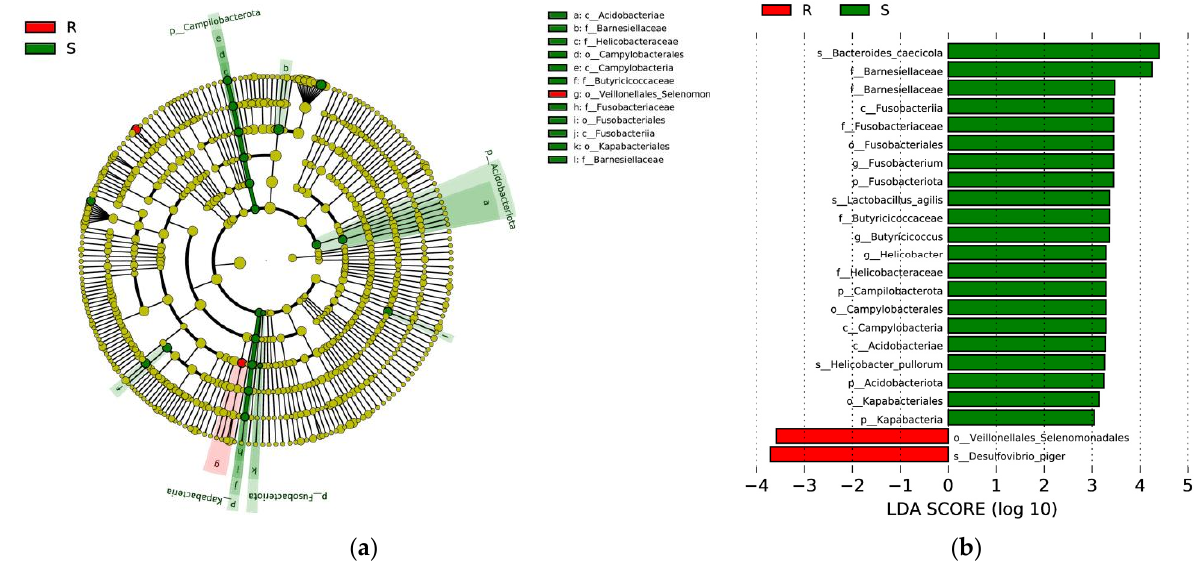
Figure 5. Linear discriminant analysis effect size (LEfSe) identified the most differentially abundant taxa between group S (green bars) and group R (red bars). ( a ) Taxonomic cladogram obtained from LEfSe analysis of 16S rRNA gene sequences. Small circles and shading with different colors in the diagram represent the abundance of those taxa in the respective group. Green circles represent taxa enriched in group S (green legend); Red circles represent taxa enriched in group R (red legend); Yellow circles represent non-significant differences in abundance between two groups. The brightness of each circle is proportional to its effect size. ( b ) Taxa enriched in group S are indicated with a positive LDA score (green), and taxa enriched in group R have a negative LDA score (red). Only those taxa with an LDA value greater than 3 are shown.